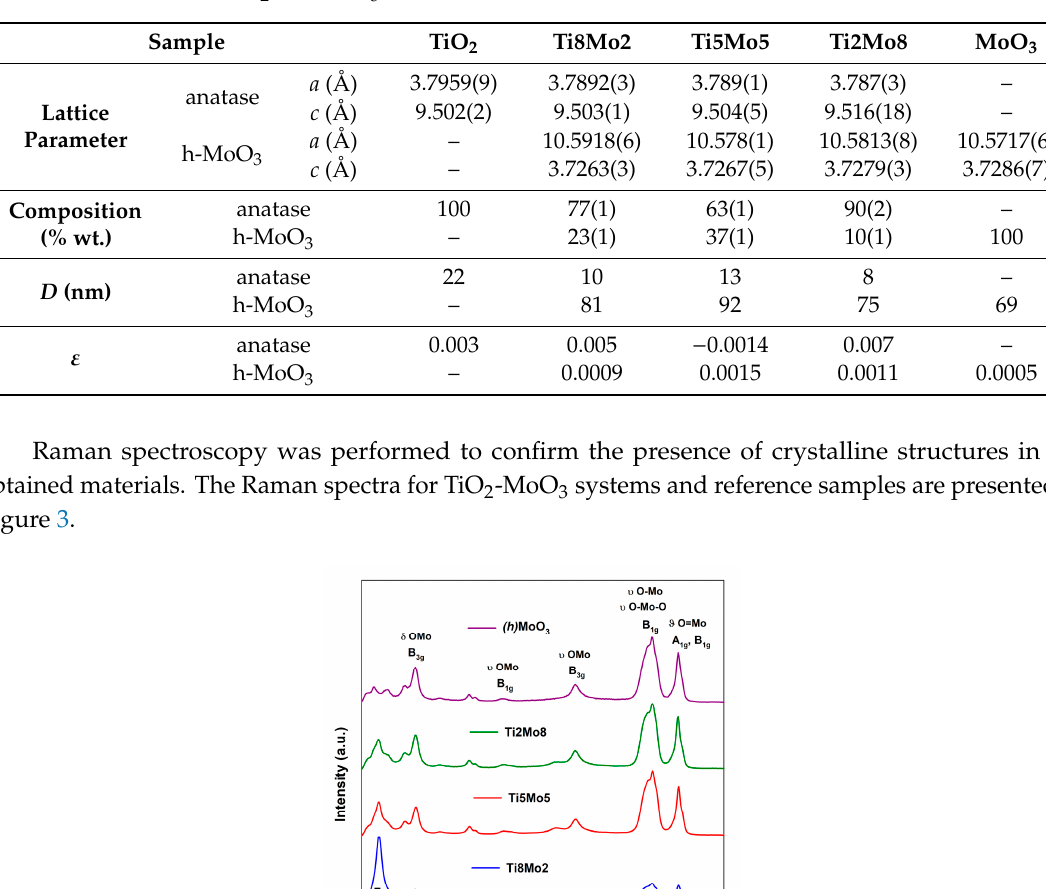
Table 2. Lattice parameters, phase composition, crystallite sizes ( D ) and lattice strain ( ε ) for synthesized materials based on TiO 2 and MoO 3 .